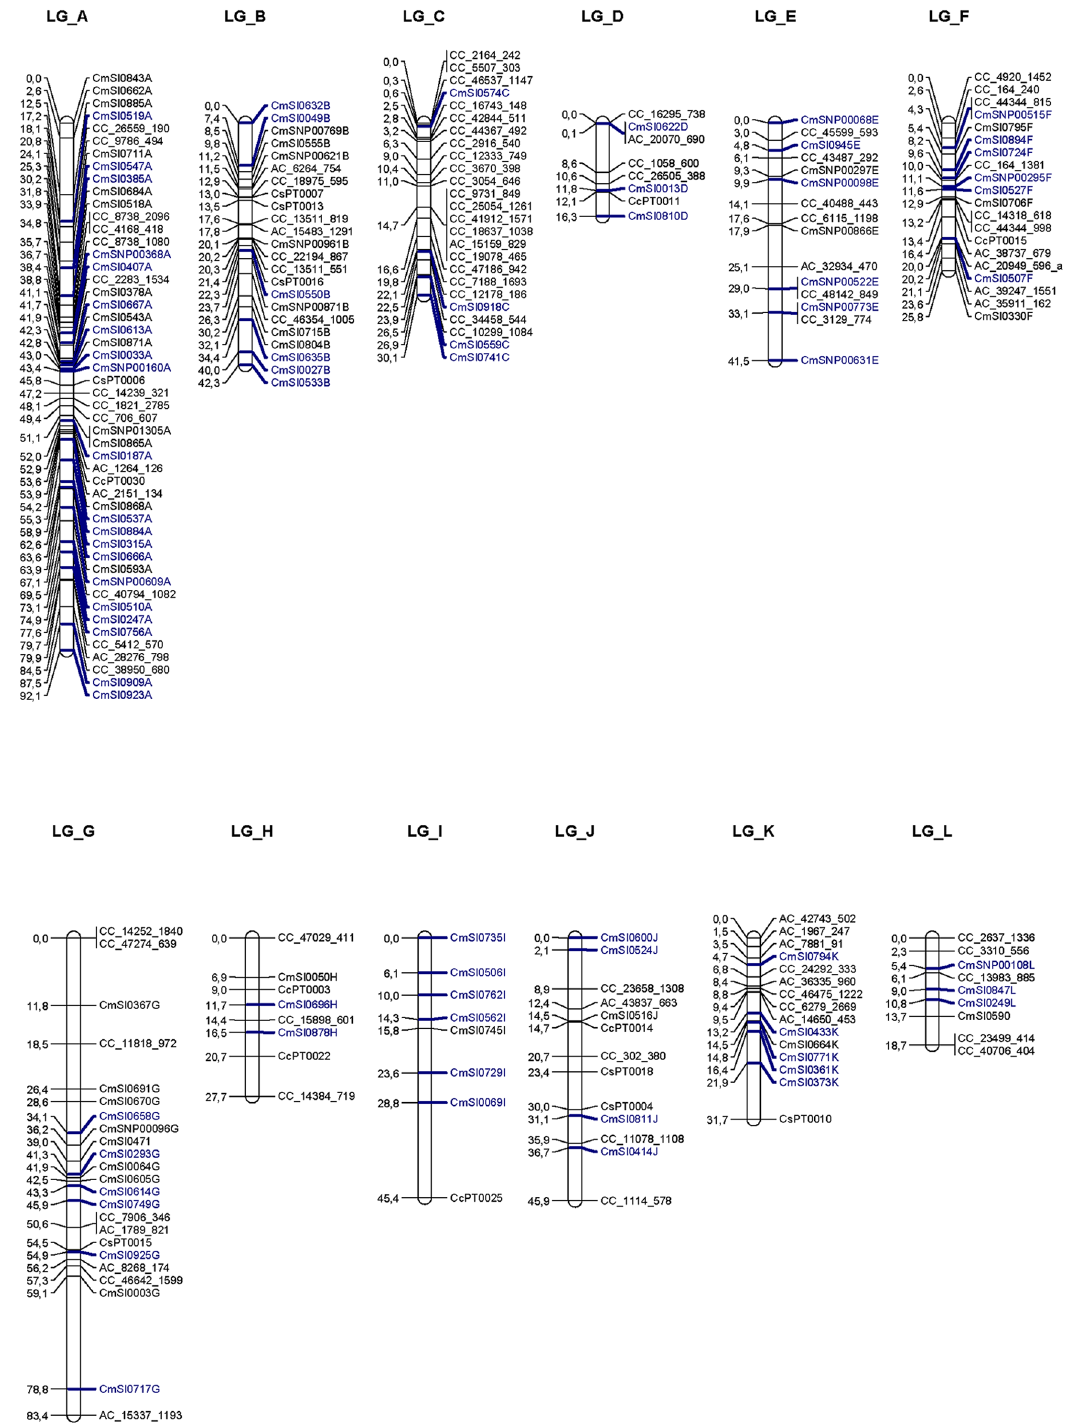
Fig 1. C . sativa x C . crenata interspecific consensus genetic map contains 217 markers(SSRs and SNPs) mapped on twelve linkage groups (LGs). Marker positionson LGs were assignedto reference map LGs [11], by using the common markers mapped on both genetic maps (in